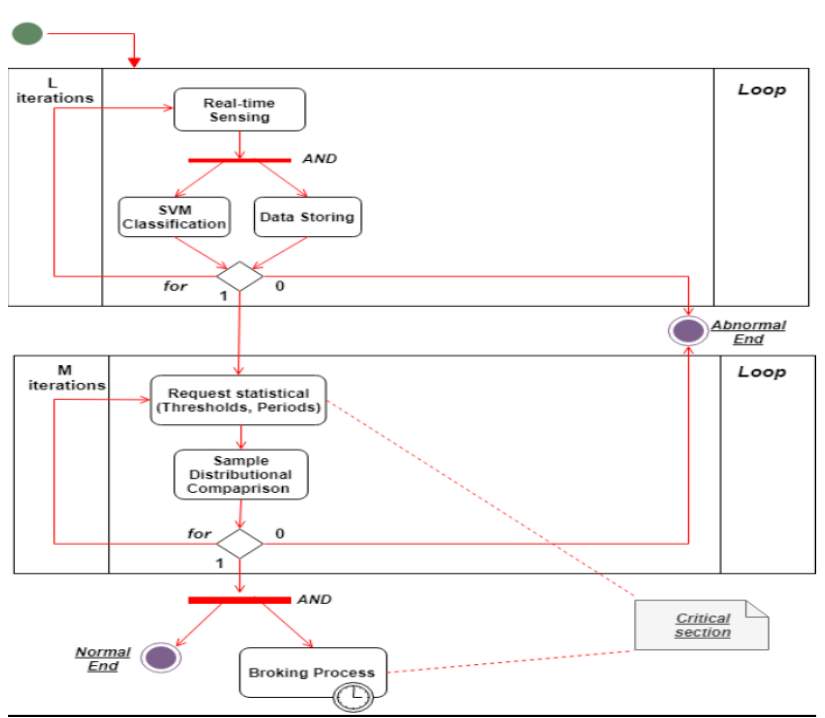
Figure 7. Activity diagram for the classification process use case (DHS) .